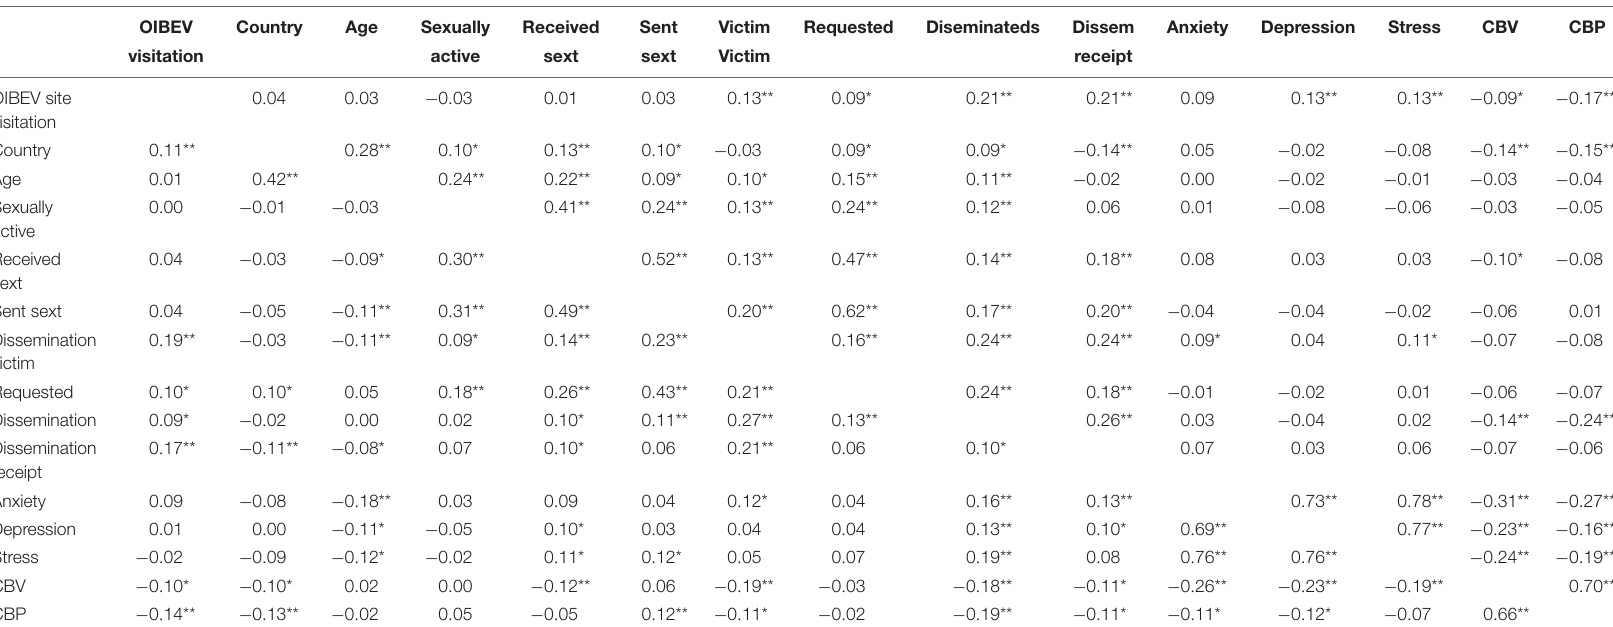
TABLE 3 | Point-biserial Correlations of OIBEV site visitation, online behaviors and mental health by gender: Upper triangle Men, lower triangle Women. OIBEV